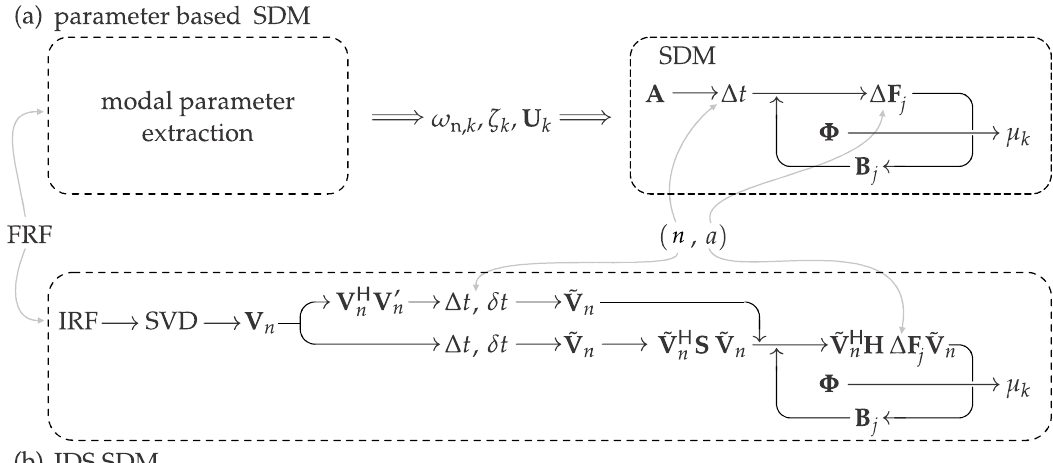
Figure 2. The flowcharts show the comparison between modal parameter-based semidiscretization method (SDM) ( a ) and the Impulse Dynamic Subspace (IDS) SDM description ( b ). Prior to the conventional modal description, modal parameter extraction is needed, while the IDS SDM description is initiated, in theory, using a known